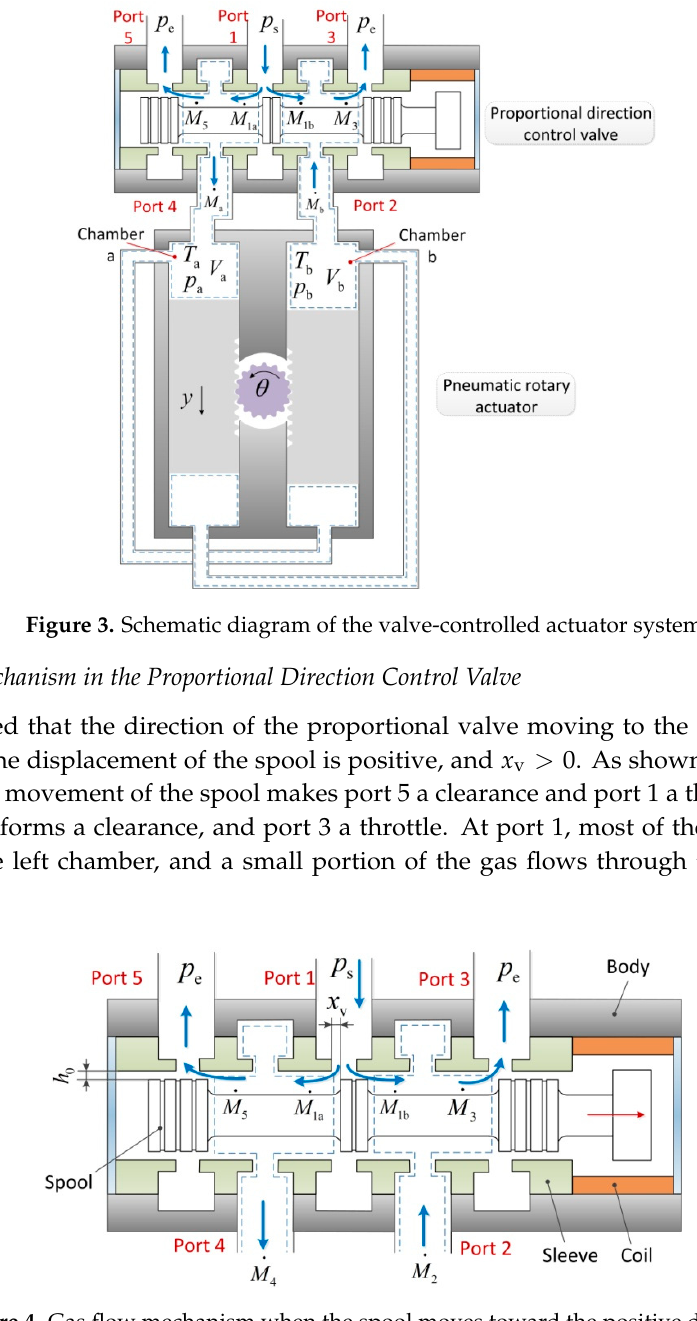
Figure 4. Gas flow mechanism when the spool moves toward the positive direction.